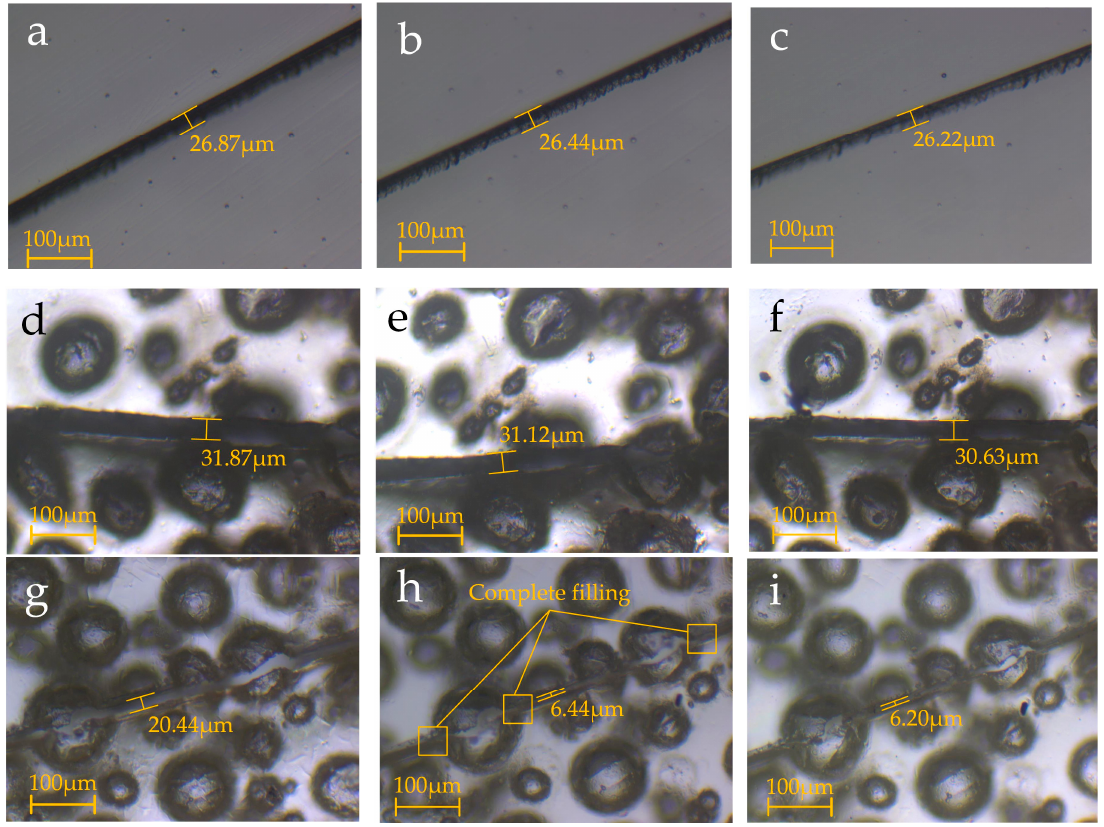
Figure 2. Morphology of the scratch: ( a ) Unheated pure LDPE epoxy resin; ( b ) Heated pure epoxy resin for 30 min; ( c ) Heated pure epoxy resin for 60 min; ( d ) Unheated composite without catalyst; ( e ) Heated composite without catalyst for 30 min; ( f ) Heated composite without catalyst for 60 min; ( g ) Unheated composite; ( h ) Heated composite for 30 min; and ( i ) Heated composite for 60 min.